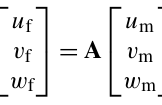
components, given that such averages are not possible on the vector